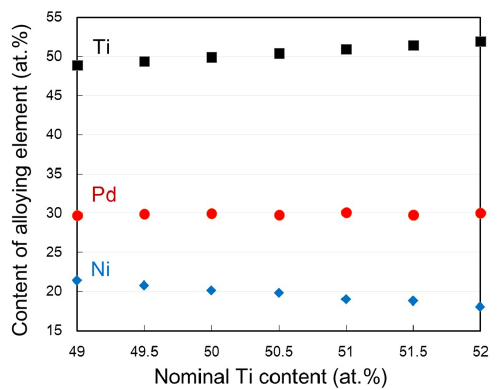
Figure 9. Ti, Ni and Pd contents of the matrix region for the (49 – 52)Ti alloys measured by EPMA.